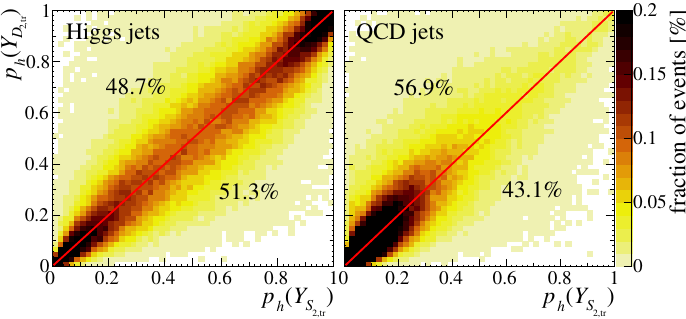
Figure 8 . The distributions of Higgs-like probability in p h ( Y S numbers in upper left and lower right area represent the fraction of events in the